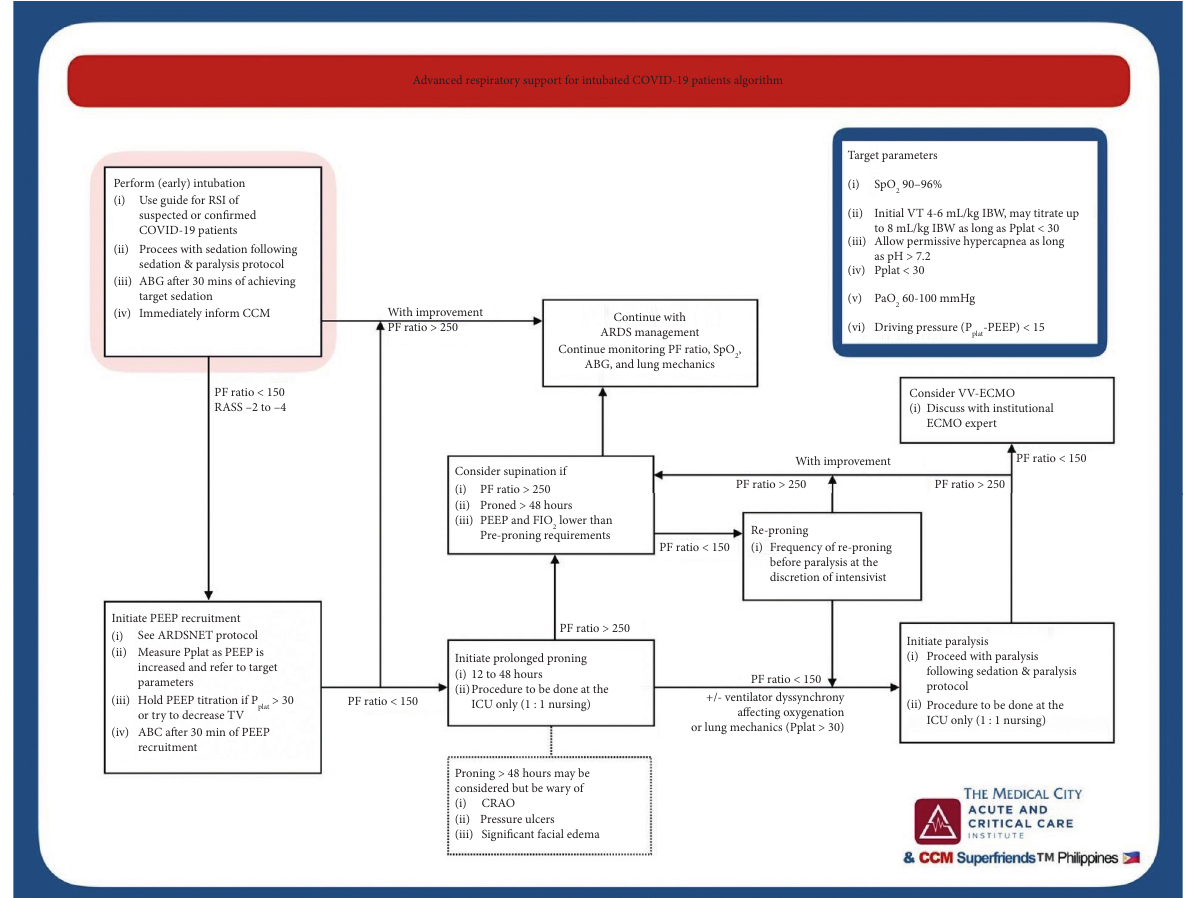
Figure 2: Advanced respiratory support for intubated COVID-19 patients